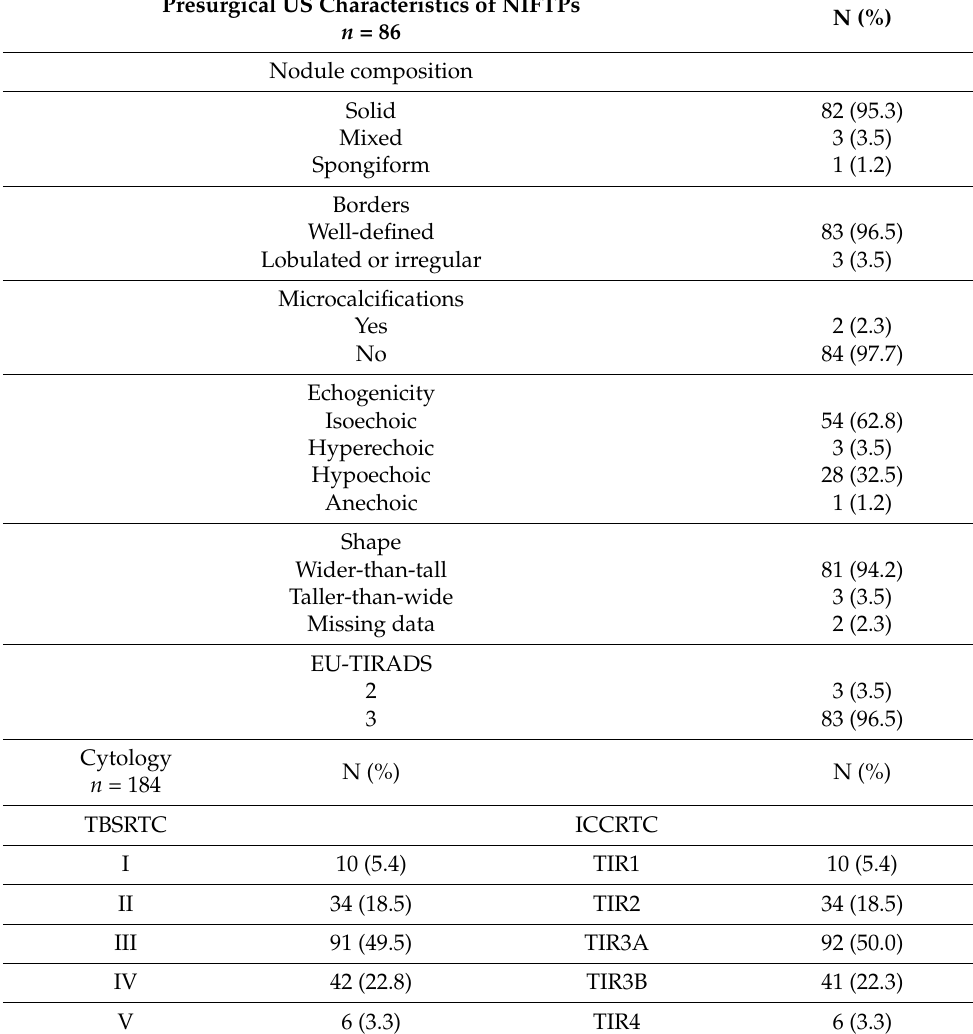
Table 4. Subset of NIFTP cases with available cytological diagnosis, ultrasound data, and molecular